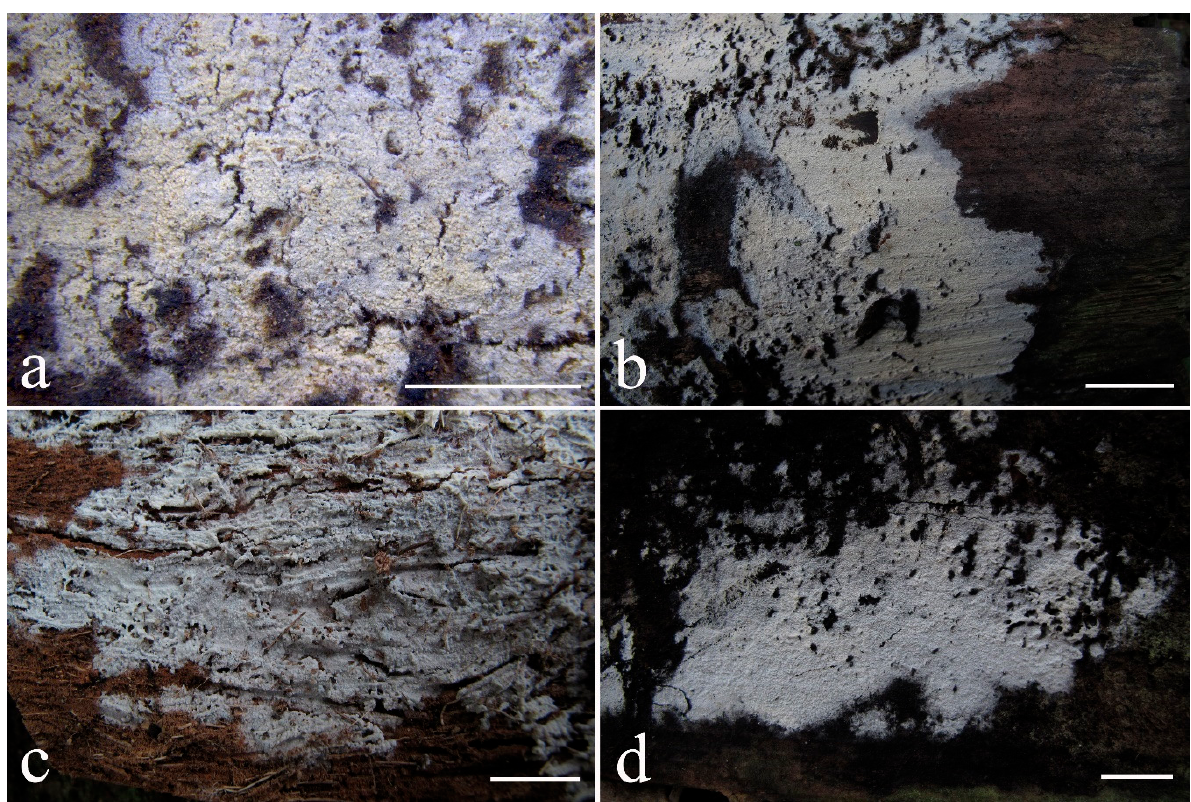
Figure 14. Basidiocarps of Lyomyces elaeidicola . ( a , b ) LWZ 20180411-20 (holotype); ( c ) LWZ 20180411-17 (paratype); ( d ) LWZ 20180411-19 (paratype).—Scale bars: a = 5 mm; b–d = 1 cm.